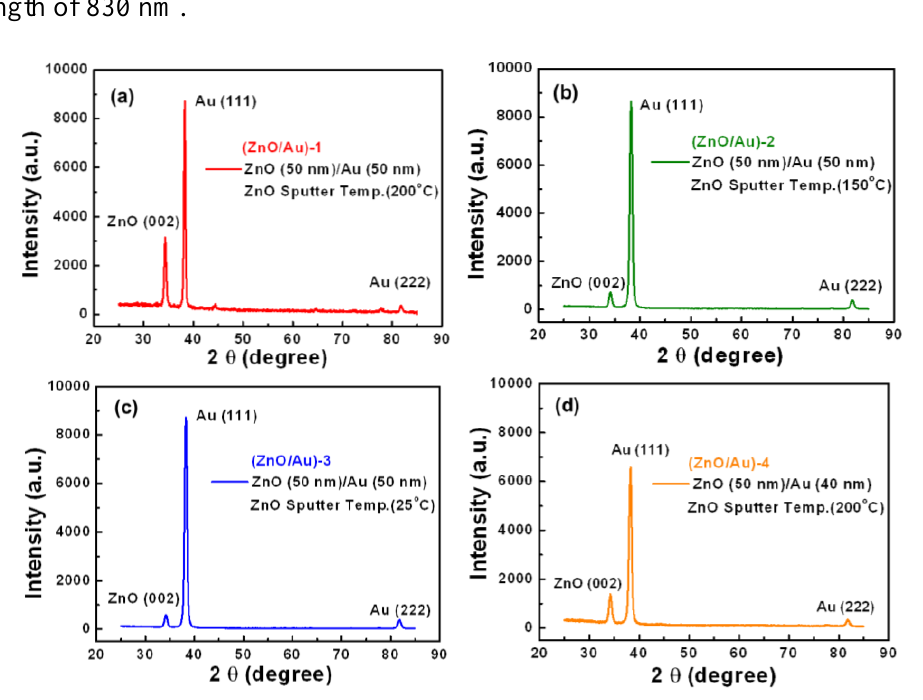
Figure 2. XRD patterns of ZnO thin films deposited on SF10 substrates under different conditions. Diffraction angle (2  ), FWHM, and XRD peak intensity for ( a ) (ZnO/Au)-1, ( b ) (ZnO/Au)-2, ( c ) (ZnO/Au)-3, and ( d ) (ZnO/Au)-4; ( e ) SPR reflectivity curves of (ZnO/Au)-1, (ZnO/Au)-2, (ZnO/Au)-3, (ZnO/Au)-4, (Cr/Au)-7 and (ITO/Au)-8, ( f ) Theoretically calculated (line) and measured (symbols) reflectance SPR spectra of (ZnO/Au)-1, (ZnO/Au)-5 and (ZnO/Au)-6 devices in water for a light source with a wavelength of 830